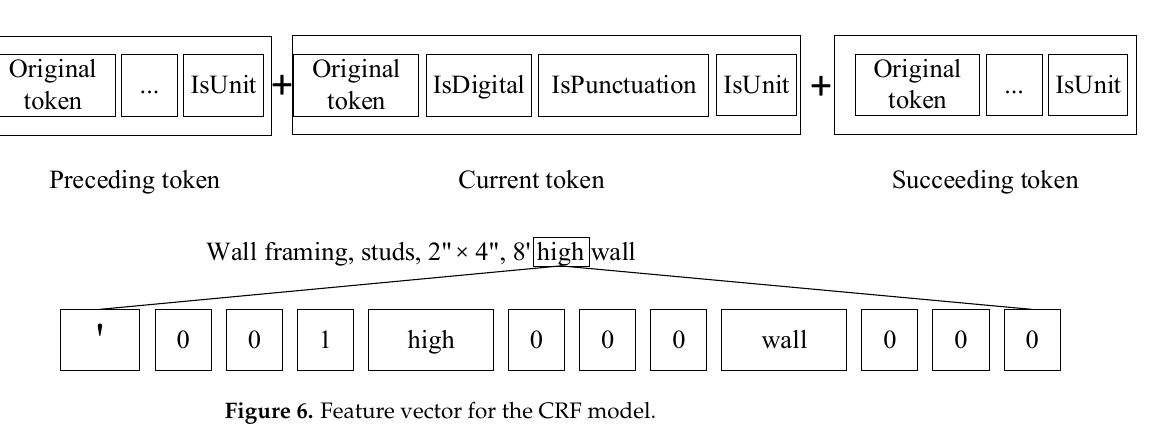
Figure 5. NER-based information extraction.